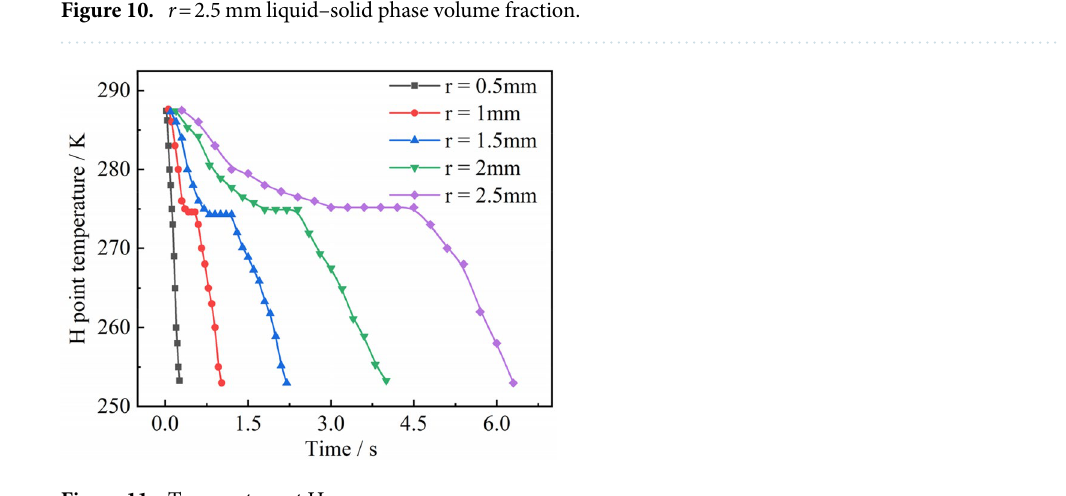
Figure 11. Temperature at H.